Question: Express in one sentence what the figure is showing.
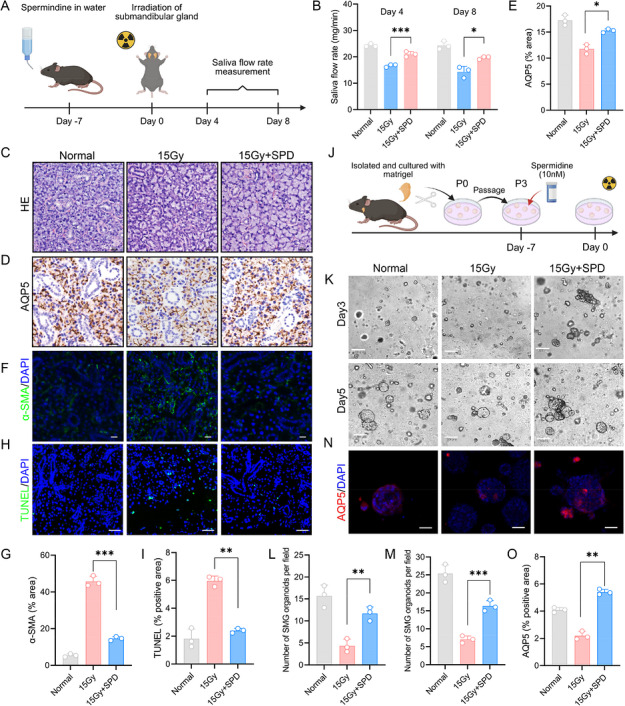
Answer: Protective effect of spermidine on radiation‐induced SMG injury. (A) Study protocol. (B) Salivary flow rate on Day 4 and Day 8 between different treated groups ( n = 3). (C) Representative H&E images of acinar cells in different groups ( n = 3). Scar bar = 50 µm. (D) Representative IHC images of AQP5 expression in different groups and (E) corresponding semi‐quantitative analysis ( n = 3). Scar bar = 50 µm. (F) Representative immunofluorescence images of α‐SMA expression in different groups and (G) correspondingly semi‐quantitative analysis ( n = 3). Scar bar = 50 µm. (H) Representative images of TUNEL expression in different groups and (I) corresponding semi‐quantitative analysis ( n = 3). Scar bar = 100 µm. (J) The scheme of construction of SMG organoids and the spermidine treatment process. (K) Number of SMG organoids (scar bar = 200 µm) on postirradiation Day 3 and Day 5, and (L, M) corresponding semi‐quantitative analysis ( n = 3). (N) Expression levels of AQP5 (scar bar = 10 µm) with (O) semi‐quantitative analysis ( n = 3). One‐way analysis of variance (ANOVA) was used for group comparisons, followed by posthoc multiple‐comparison testing. Data are presented as mean ± SD. * p < 0.05; ** p < 0.01; *** p < 0.001.